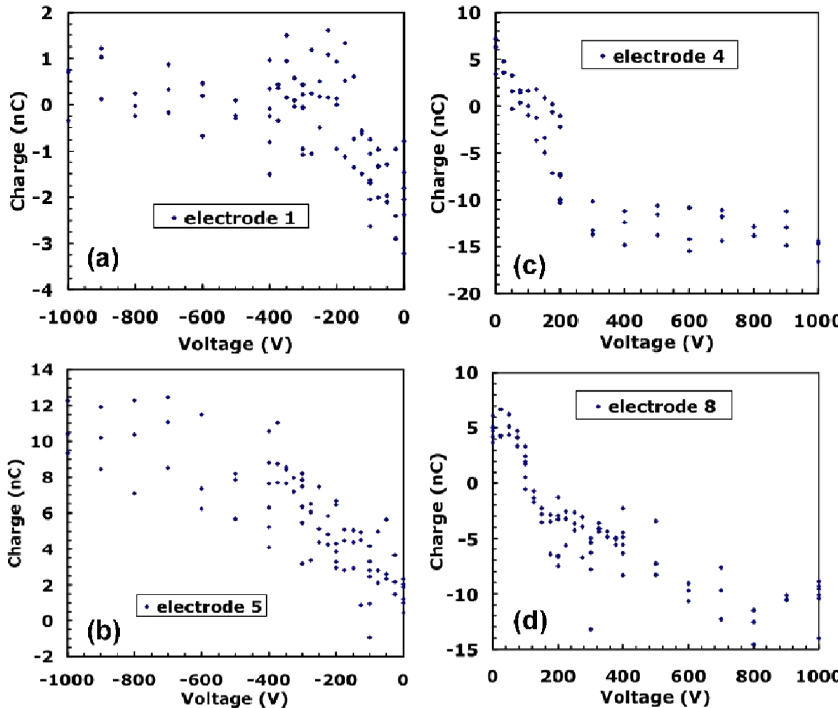
FIG. 8. (Color) Charge collected as a function of bias voltage for: (a) electrode 1; (b) electrode 5; (c) electrode 4; (d) electrode